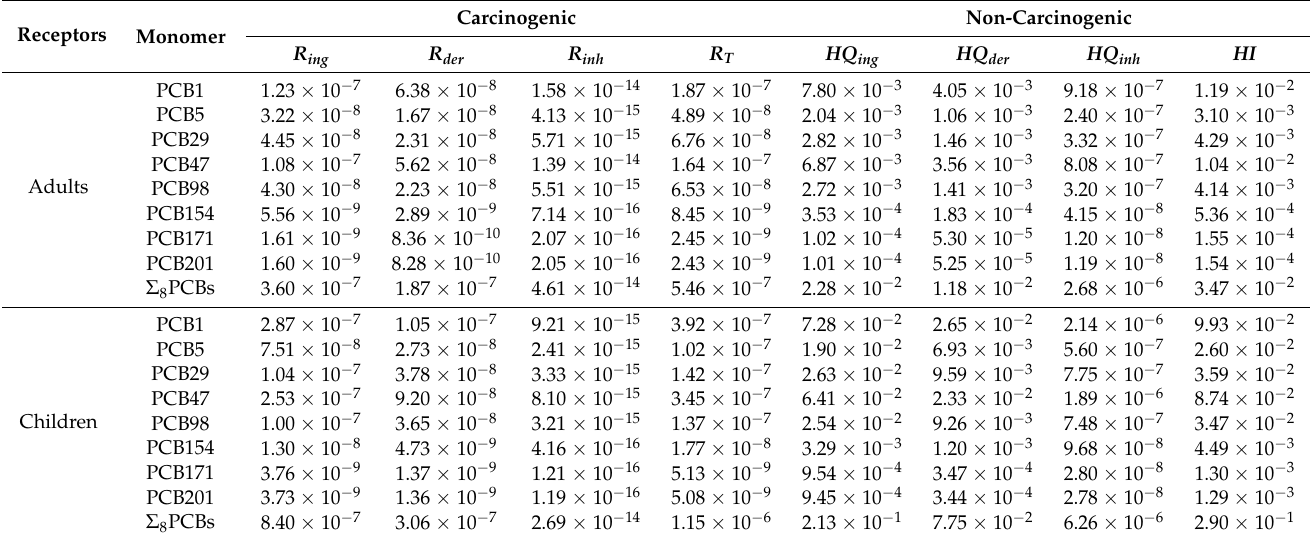
Table 5. Carcinogenic and non-carcinogenic risks of PCBs in 0–20 cm soil.